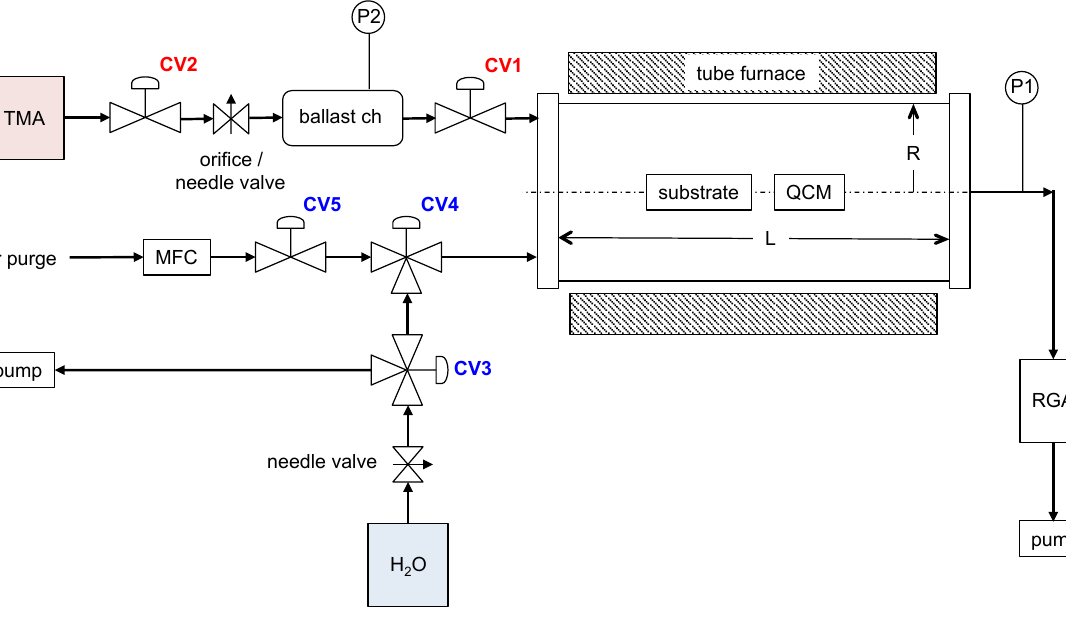
Figure 3. A schematic diagram of the laboratory-scale ALD reactor system to be modeled.